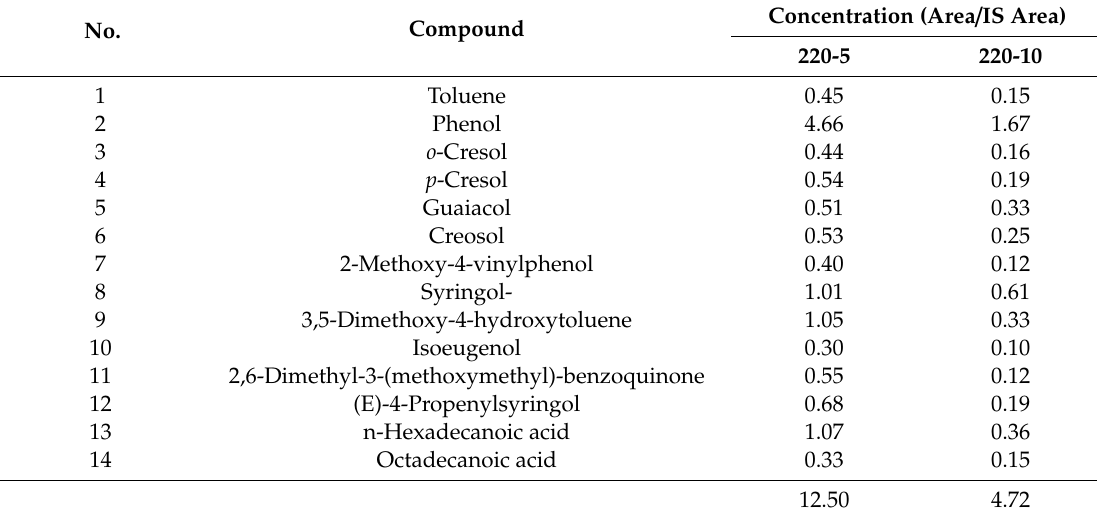
Table 7. Qualitative and quantitative analysis of chemical compounds in the organosolv lignin from